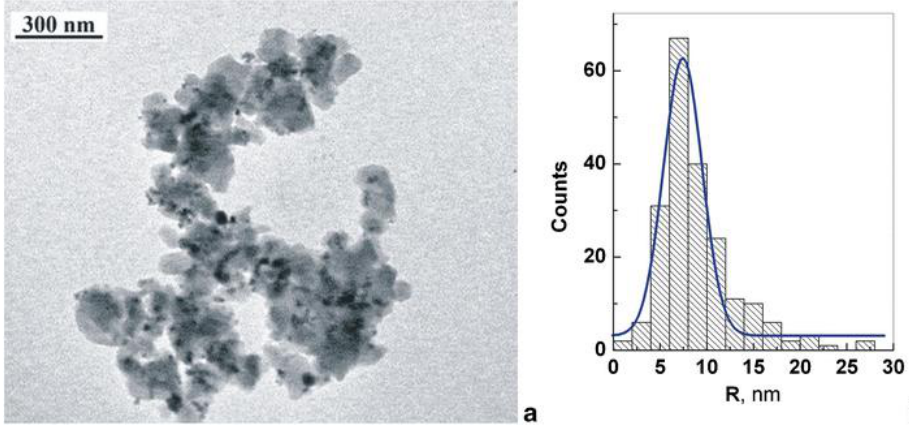
Figure 6. ( a ) TEM micrograph of Fe 3 O 4 nanoparticles embedded in a fragment of commercial hyper-crosslinked polystyrene MN200 (Purolite Int., UK); ( b ) histogram and differential function of magnetite nanoparticles size distribution (200 particles from 12 nanocomposite fragments). Reprinted by permission from Springer (Berlin, Germany) [76], copyright 2014.